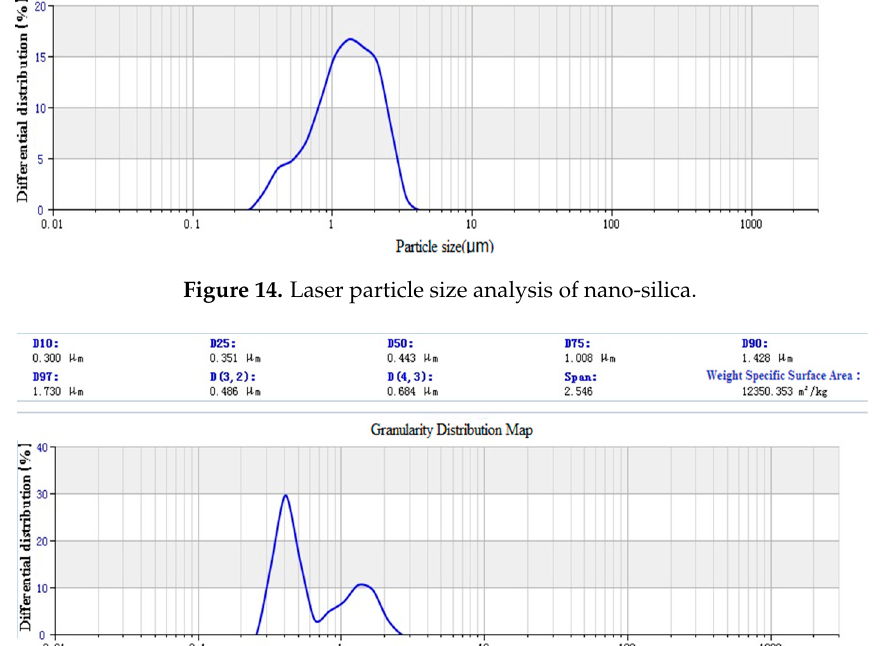
Figure 14. Laser particle size analysis of nano-silica.